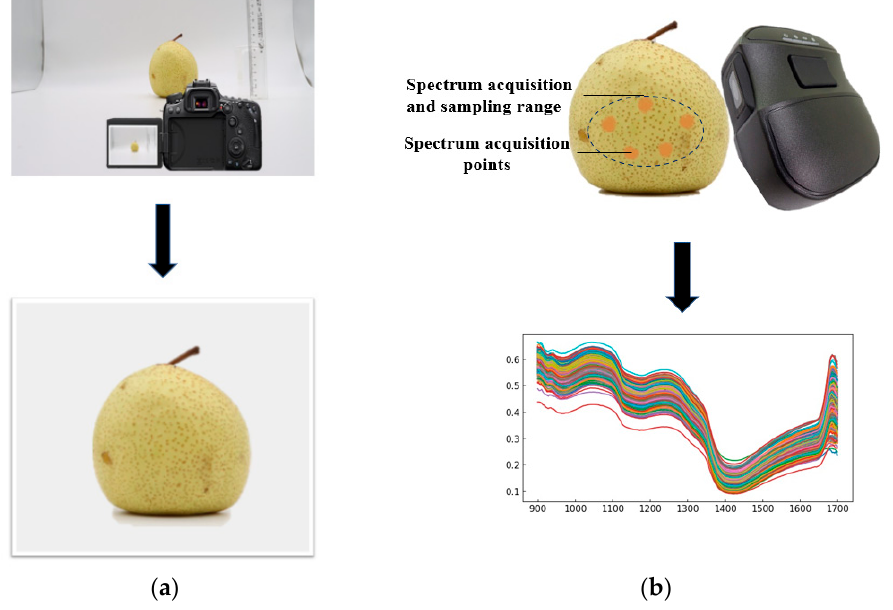
Figure 3. Sample collection process: ( a ) spectral data acquisition of samples; ( b ) image data acquisi- tion of samples.